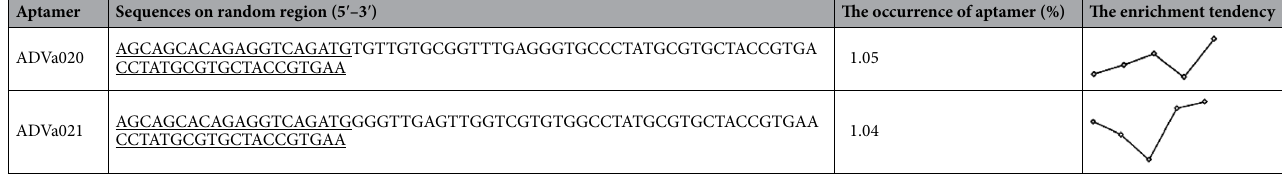
Table 1. Aptamer sequences occurring with > 1% frequency in the top 100 enriched aptamers. a Underlined bases indicate the constant regions.